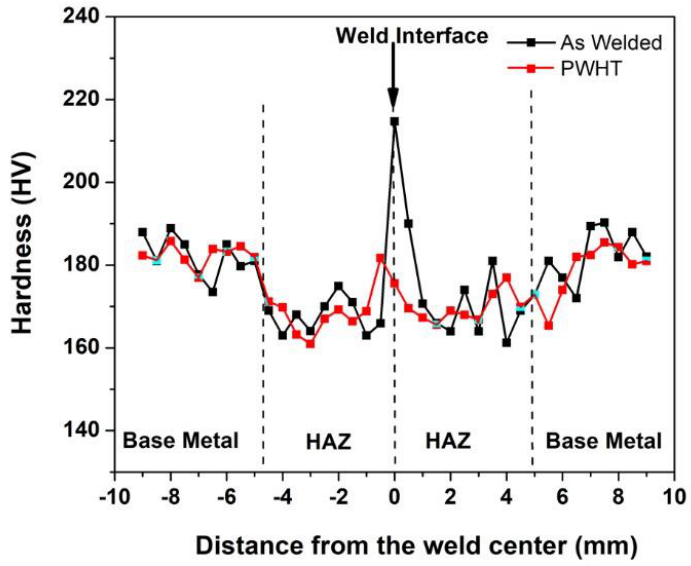
Figure 5. The hardness distribution across the weld interface of the alloy 800H friction weld joints in as-welded and PWHT condition.